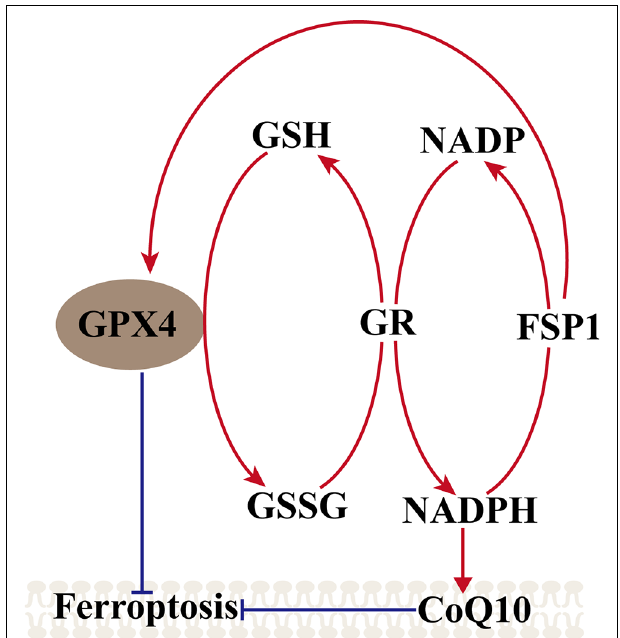
FIGURE 2 | Mechanism of ferroptosis, ferroptosis suppressor protein 1 (FSP1)–coenzyme Q10 (CoQ10)–NAD (P)H pathway. GPX4 utilizes the GSH as a substrate to reduce lipid hydroperoxides and inhibited the ferroptosis, GSSG generated by GPX4 is reduced back to glutathione by GR in Nicotinamide Adenine Dinucleotide Phosphate (NADPH), ferroptosis suppressor protein 1 (FSP1) can complement the loss of GPX4, conferring protection against ferroptosis, and FSP1 catalyzes the regeneration of CoQ10 through NAD (P)H. NAD (P)H also can inhibit the ferroptosis via CoQ10.